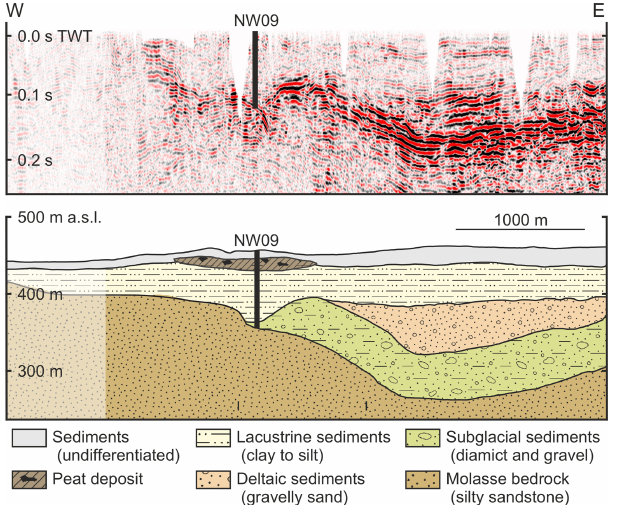
Figure 3. Top: seismic survey data along a NW–SE profile parallel to the main valley axis. Bottom: sedimentary facies model of the overdeepened trough of Niederweningen (modified after Dehnert et al.,